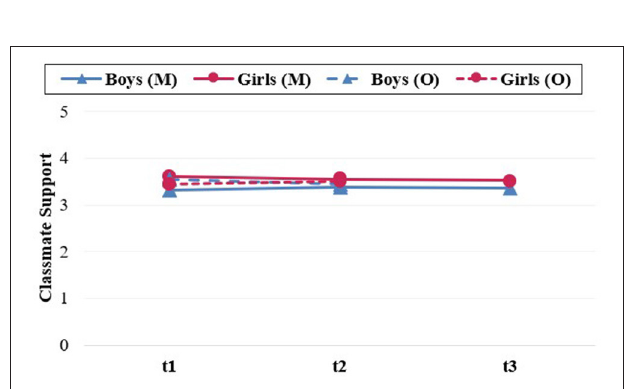
FIGURE 2 | Turkish students’ classmate support over time separated by cohort and